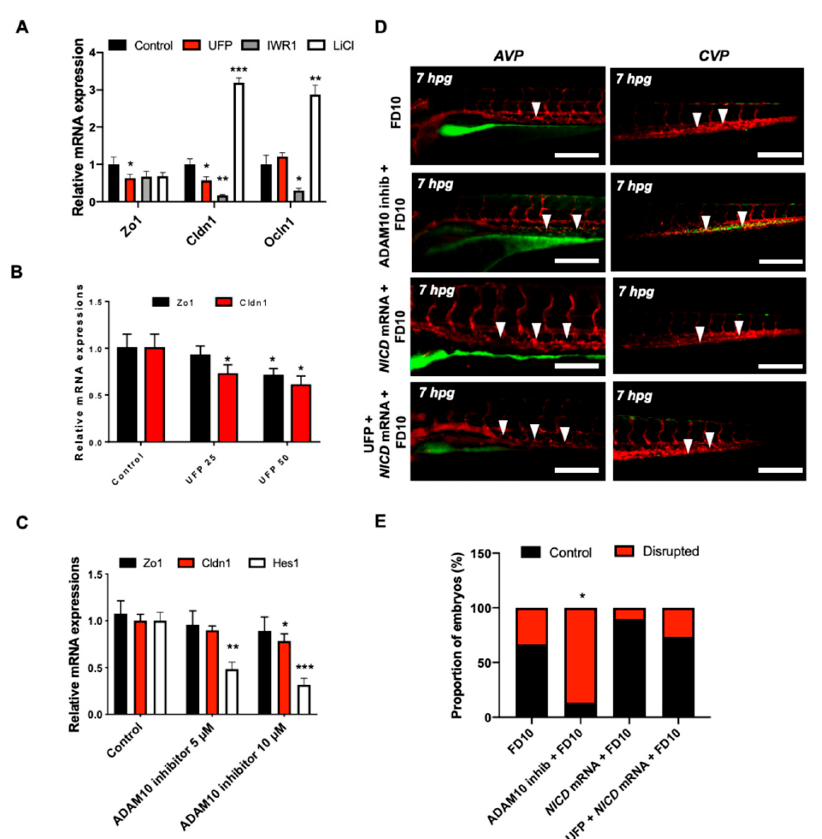
Figure 4. UFP exposure down-regulates mRNA expressions of endothelial tight junction (TJ) protein and the Notch target gene to disrupt the GVB. mRNA expressions of TJ proteins, including zonula occludens1 (Zo1), claudin 1 (Cldn1), and occludin 1 (Ocln1), and the Notch target genes, including Hairy and enhancer of split-1 (Hes1), were assessed in vitro by cultured human aortic endothelial cells (HAEC). ( A ) UFP exposure (25 µg·mL − 1 for 6 h) inhibited Zo1 and Cldn1 mRNA expressions, whereas Ocln1 mRNA remained unchanged. While Iwr1 treatment (10 µM) diminished overall TJ mRNA expression, LiCl (20 mM) up-regulated Cldn1 and Ocln1 mRNA expression ( * p < 0.05 vs. DMSO for Iwr1, H 2 O for LiCl, n = 3, ** p < 0.01, *** p < 0.001). ( B ) UFP exposure (25–50 µg·mL − 1 for 6 h) down-regulated both TJ (Zo1 and Cldn1 mRNA) and Notch target genes (Hes1) mRNA expression in a dose-dependent manner ( * p < 0.05 vs. H 2 O, n = 3). ( C ) Treatment of Adam10 inhibitor (5 µM) to inhibit Notch receptor activation down-regulated Cldn1, and Hes1 mRNA in a dose-dependent manner ( * p < 0.05 vs. DMSO, n = 3, ** p < 0.01, *** p < 0.001) ( D ) Micro-gavage with Adam10 inhibitor promoted transmigration of FD10 to both AVP and CVP. Micro-injection of NICD mRNA restored UFP- and Adam10 inhibitor-mediated effect. ( E ) Percentage of embryos exhibiting endoluminal FD10 fluorescence ( * p < 0.05 vs. FD10, n = 10 per group).